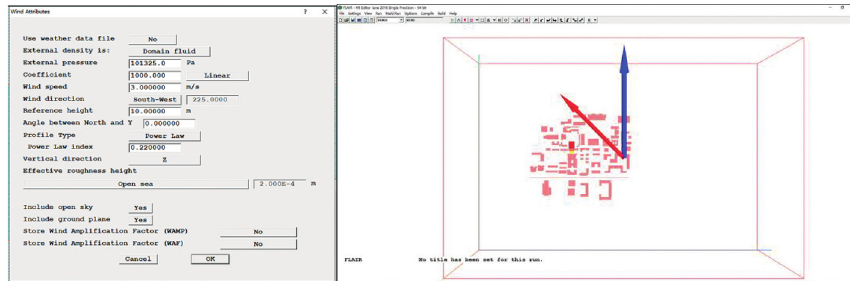
Figure 10: Wind attributes in